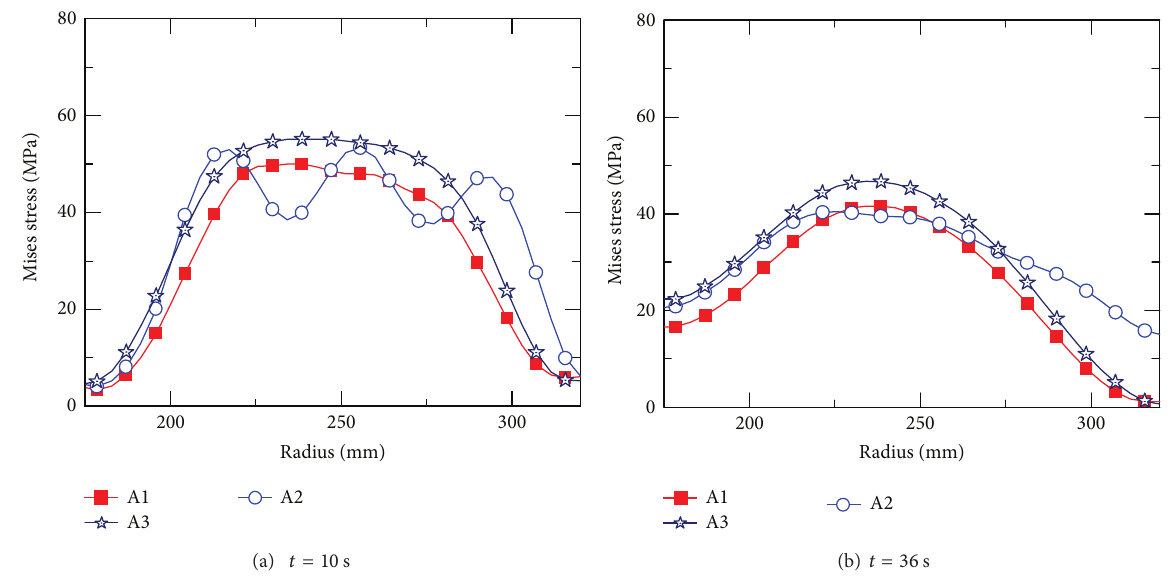
Figure 5: Variations of brake disc Mises stress in depth